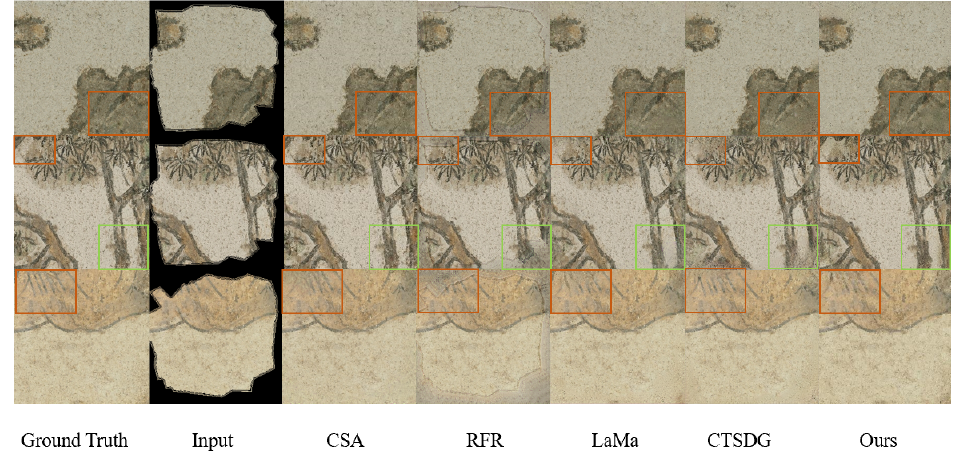
Figure 14. Comparison of inpainting results for each model on the epitaxial masks. Our model works best and looks more similar to the original after the